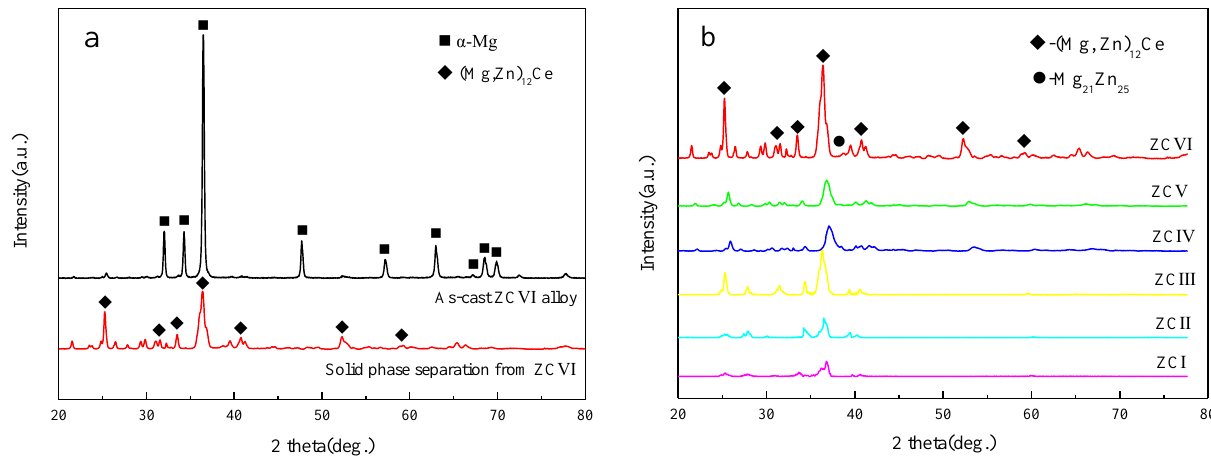
Figure 4. XRD results of as-cast alloy and its solid separation. ( a ) ZCVI, ( b ) Comparison of XRD results of alloy solid phase separation.